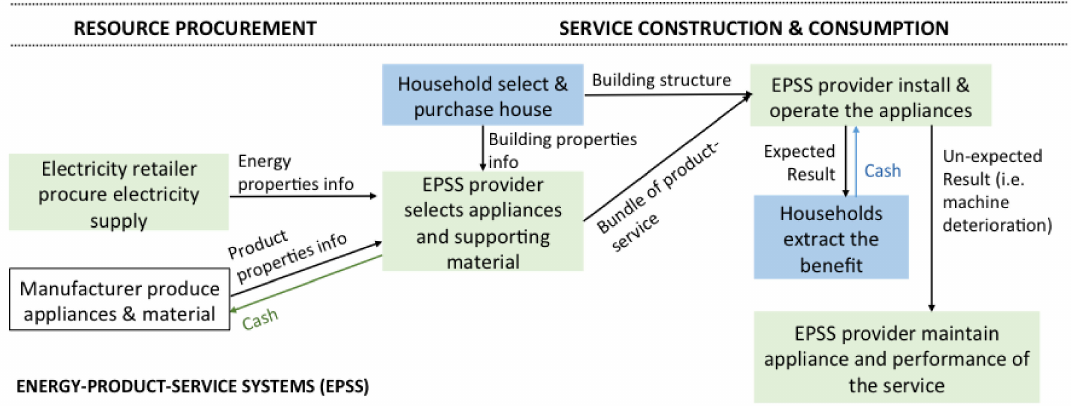
Figure 8. Product/Service and Cash Flow in